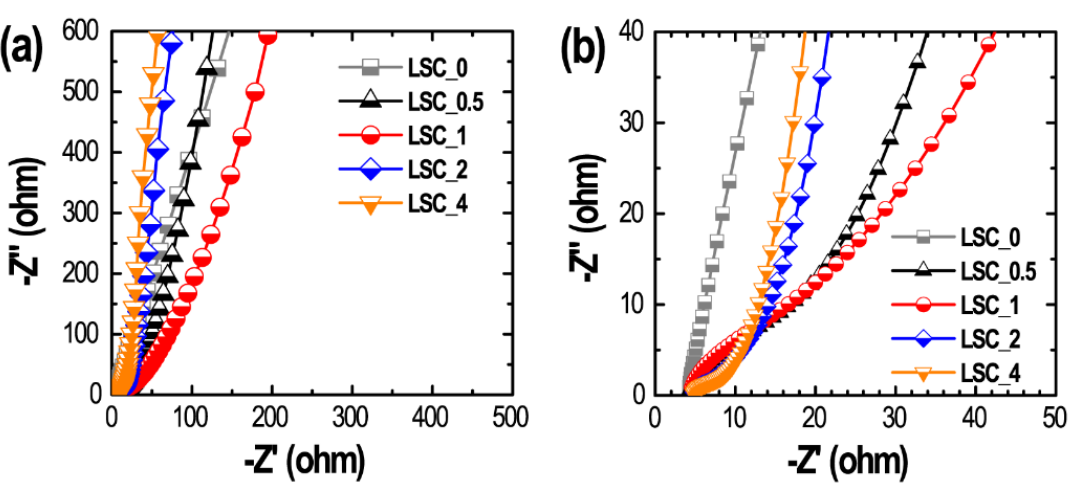
Figure 7. ( a ) Nyquist plots for different electrodes materials ( LSC_0 , LSC_0.5 , LSC_1 , LSC_2 , and LSC_4 ) in 1 M H 2 SO 4 electrolyte over the frequency range from 0.01 Hz to 100 kHz, and ( b ) corresponding magnified Nyquist plot.